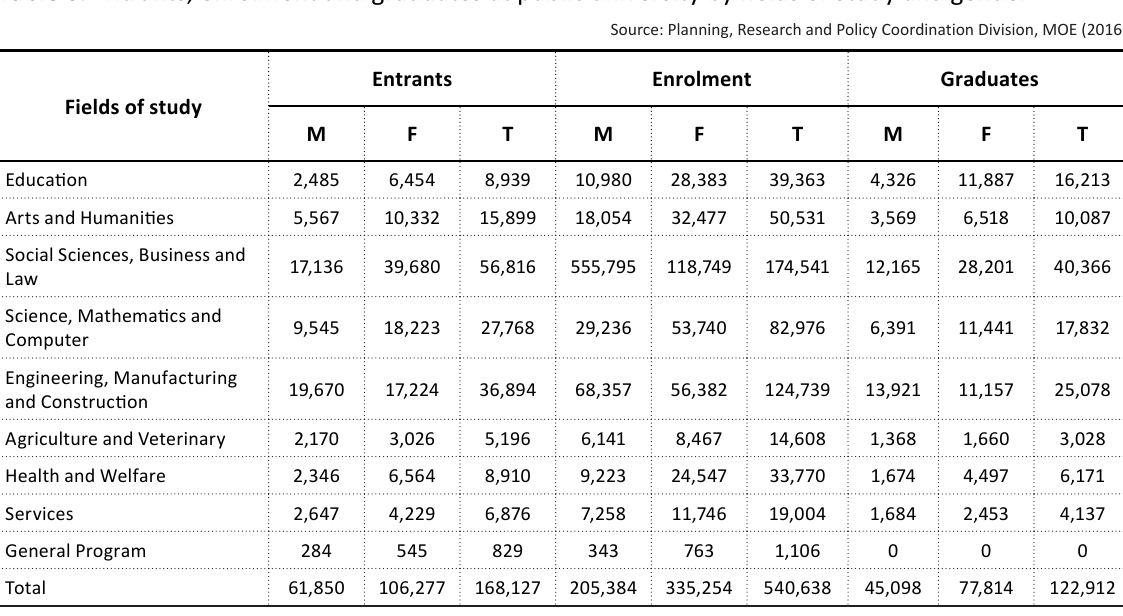
Table 5. Number of public universities enrolment